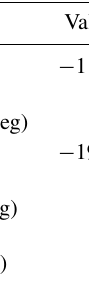
Table 2. Model input parameters of the simple evaporation model for pan evaporation experiments. The isotopic composition of ini- tial water and atmospheric vapour was determined by measurement. The effective evaporation time interval was assumed to correspond to the period when T > 0 ◦ C to account for the freezing of water in the pans during the night.